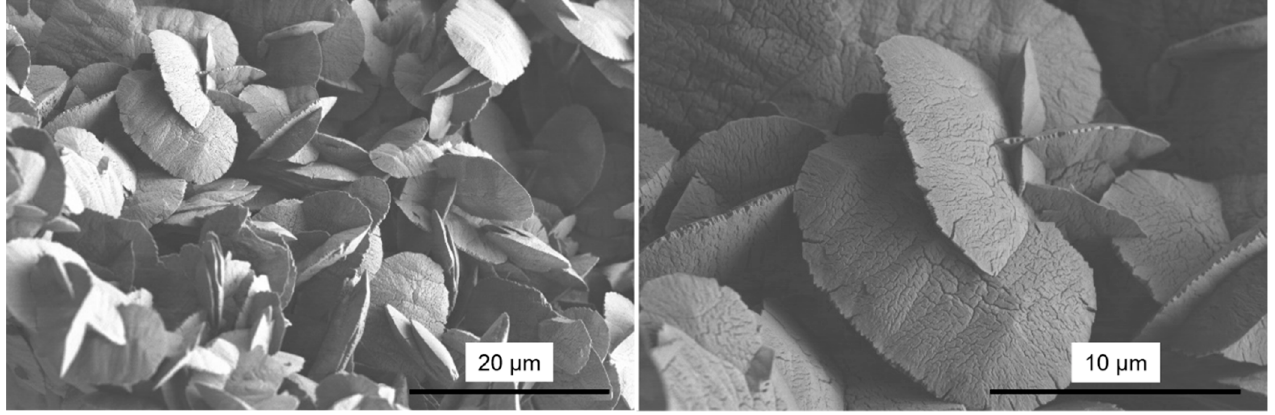
Figure 7. SEM images of the REE precipitate.